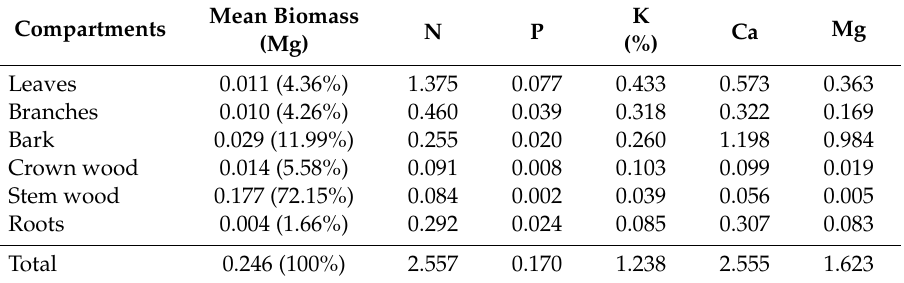
Table 4. Mean biomass and percentage of nutrients per tree component in a eucalypt stand.